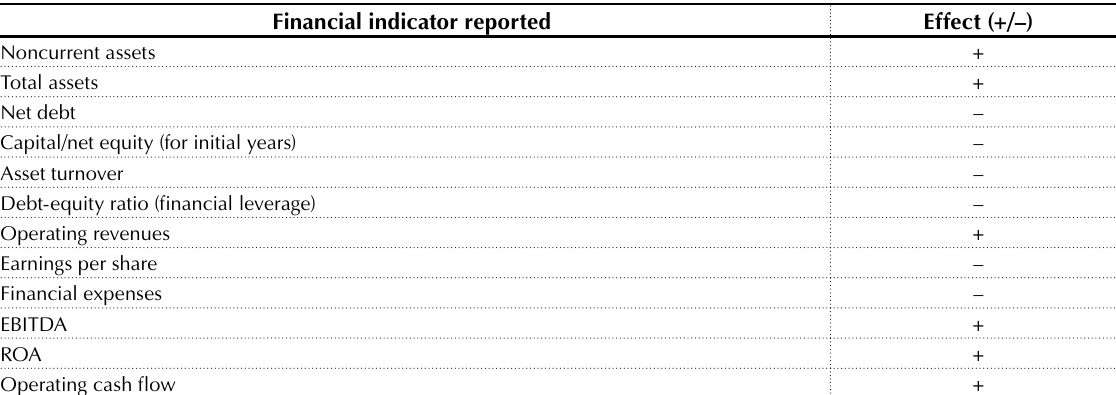
Source: Developed by the